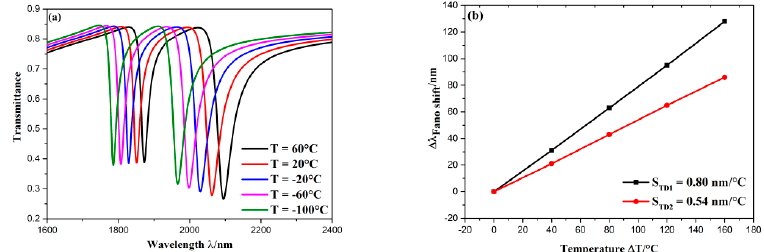
Figure 9. ( a ) Transmission spectra of diverse temperature; ( b ) the fitting line of sensitivity at D1 and D2.